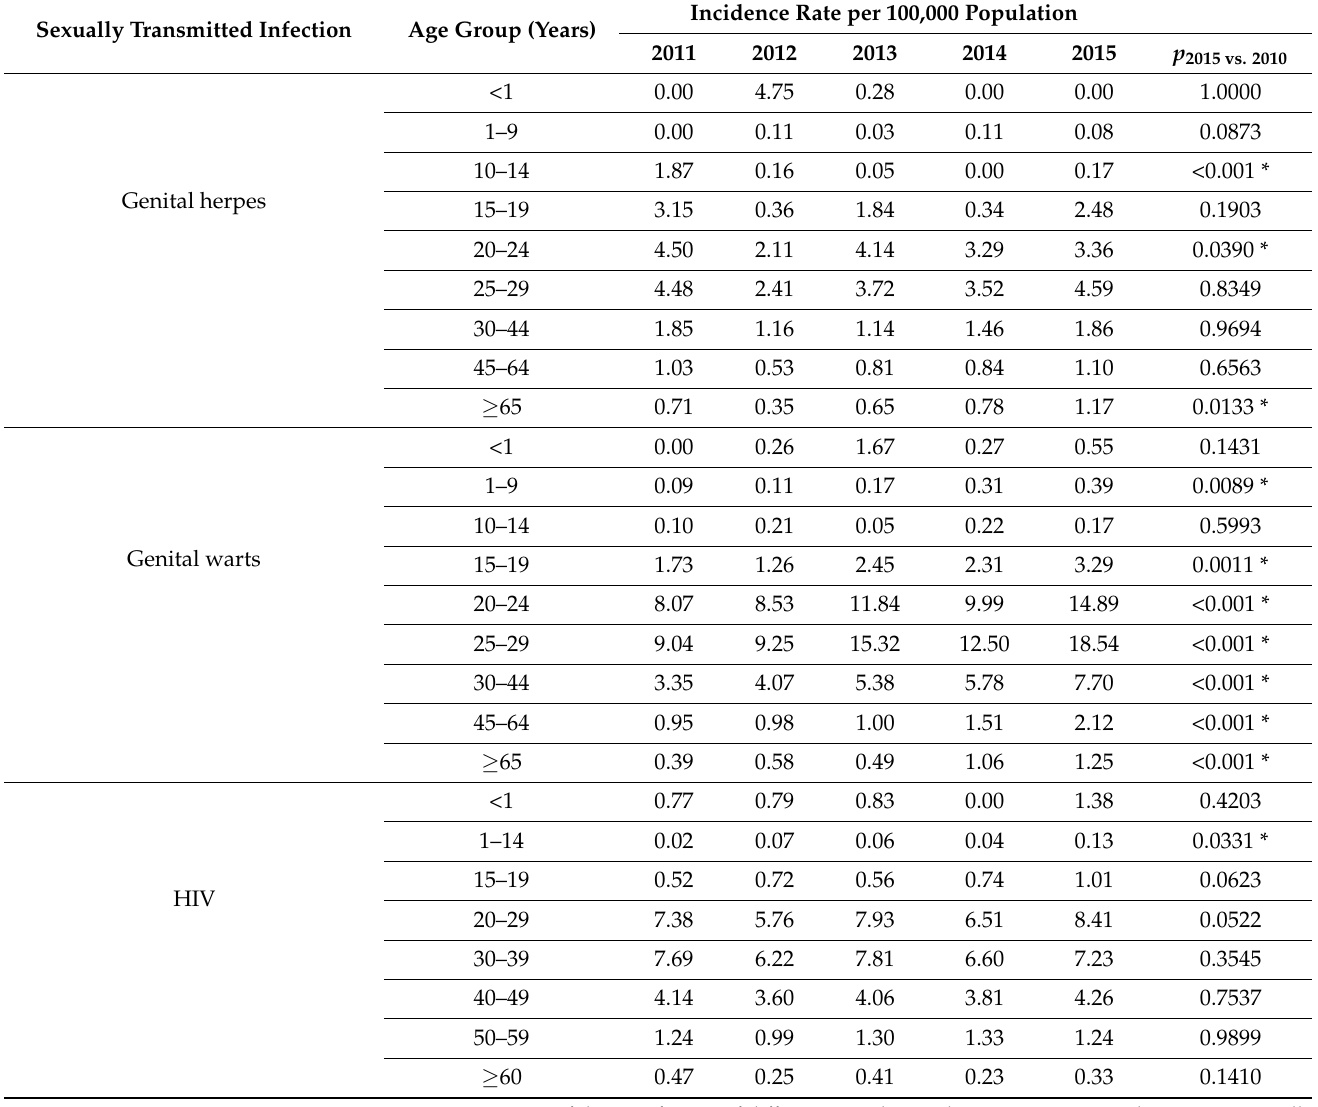
Table 3. Incidence of selected STVIs in age groups by year per 100,000